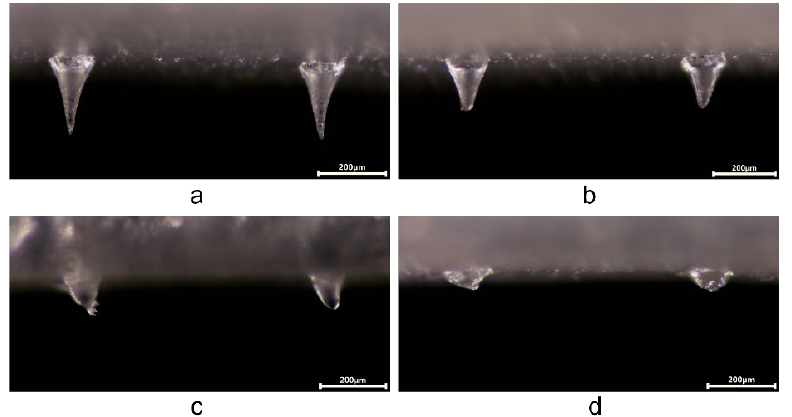
Figure 2. The self-repair time of pinhole array on rats’ skin after DMNs with different needle lengths were inserted ( a ): 230 μm; ( b ): 500 μm; ( c ): 700 μm.